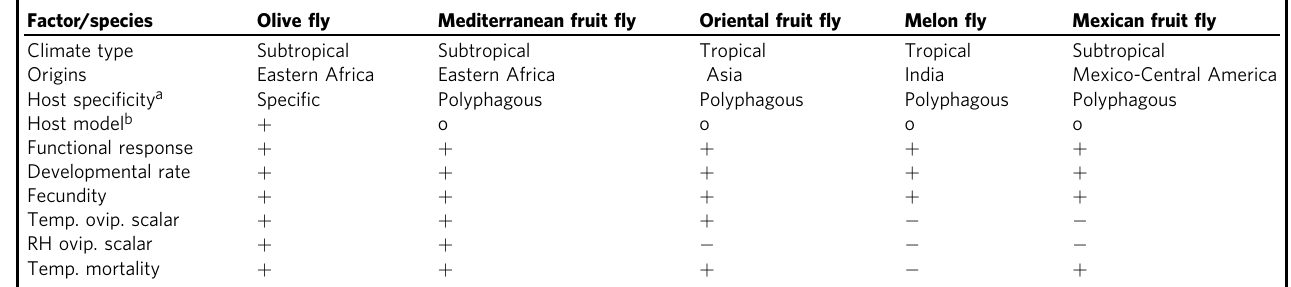
Table 1 Relative adequacy of data used to parameterize the BDFs for fi ve invasive fruit fl y species: a host range is polyphagous, or host speci fi c, b adequacy of data: suf fi cient ( + ), marginal (-), insuf fi cient (o).